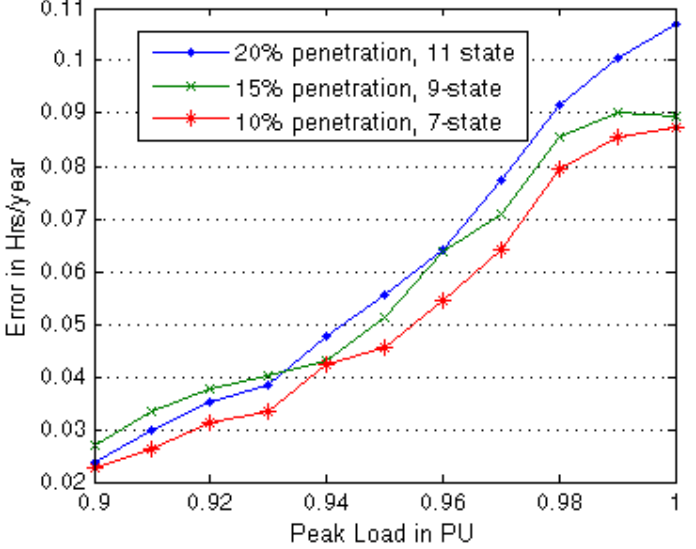
Figure 11. LOLE errors at different peak loads obtained using the recommended wind capacity